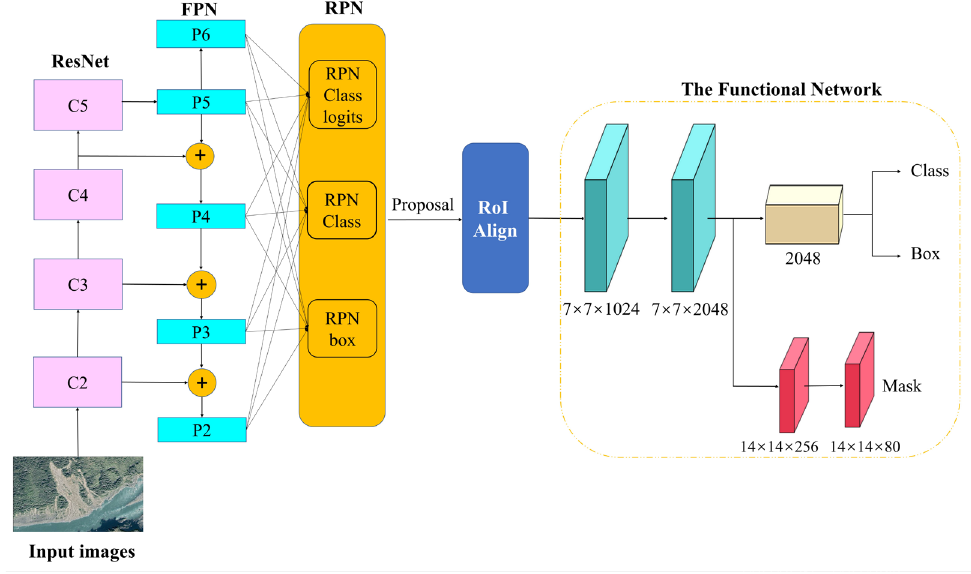
Figure 5. The architecture of the Mask R-CNN for landslide recognition.